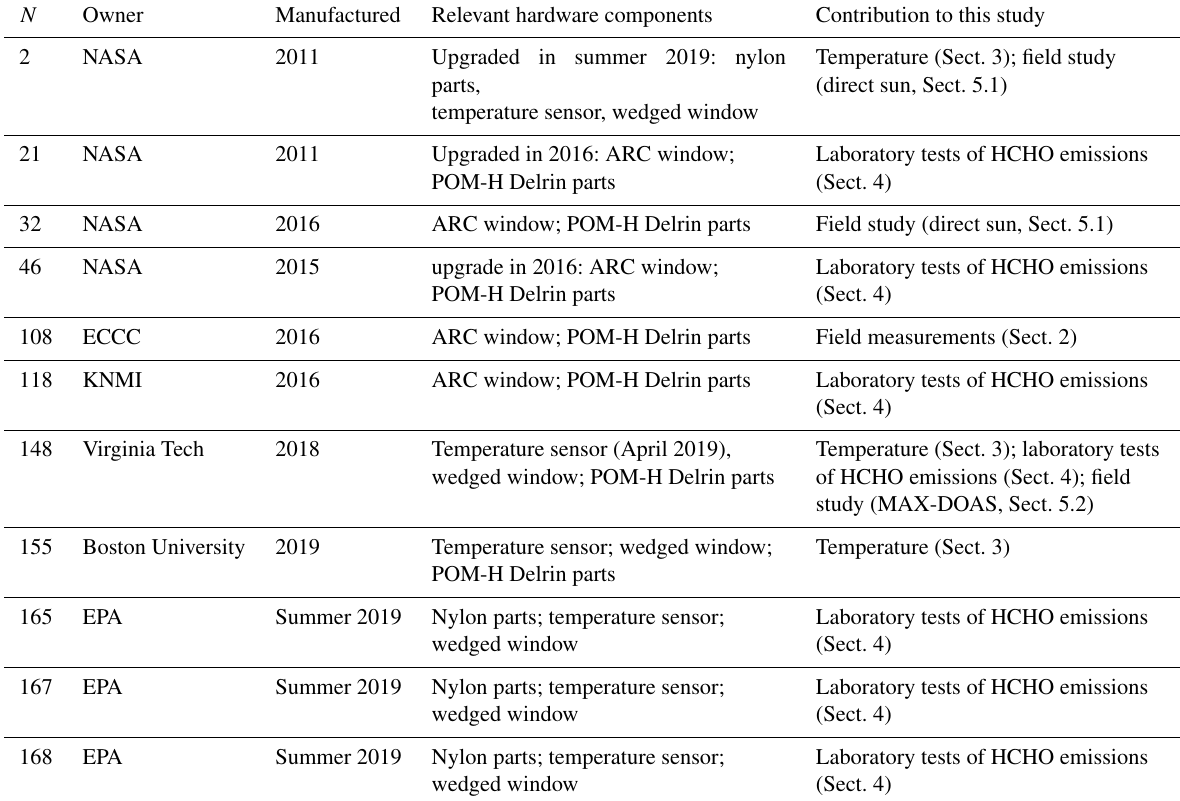
Table 1. Pandora instruments used in this